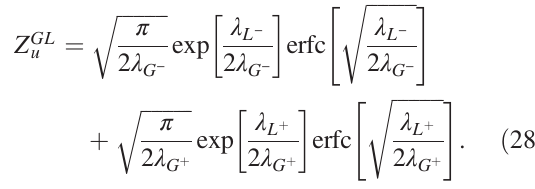
FIG. 6. Measurements of the change in stochastic displace- ments of a macrophage membrane in response to stimulation by the cytokine IFN γ . Membrane fluctuations of adhered macro- phages were measured with dynamic optical displacement spectroscopy (DODS) [23]. Details about the preparation of macrophages and DODS can be found in Ref. [23]. Two distributions correspond to IFN γ -stimulated (red dots) and resting macrophages (blue dots). Lines are theoretical fits obtained using Eq. (27). Inset: probability distributions derived from the un- normalized fitted curves.